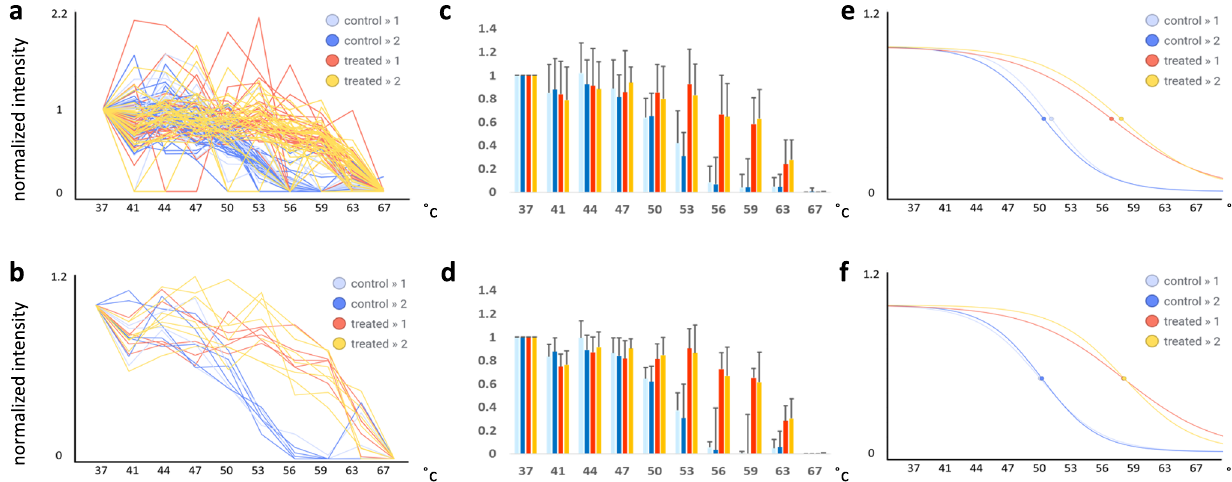
Fig. 7 Assessment of signal intensity and average reporter ion SN -1 at the lowest temperature treatment thresholds can decrease variability for an identi fi ed target ’ s in fl ection point. Top panels include all PSMs, while bottom panels have no shared peptides, an average repoter ion SN -1 of ≥ 10 and a 126-reporter ion abundance of > 70,000. a Overlay of all PSMs corresponding to MEK2. b Trendlines plotted for MEK2-derived PSMs excluding PSMs corresponding to (i) shared peptides, (ii) average reporter ion SN -1 ratio < 10, and (iii) abundance of TMT 126 reporter ion < 70,000. Mean normalized PSM values for each temperature point for all PSMs c , and after fi ltering d . The mean normalized PSM values for MEK2 were fi tted to a logistic regression model with in fl ection points shown as circles without e and with fi ltering f